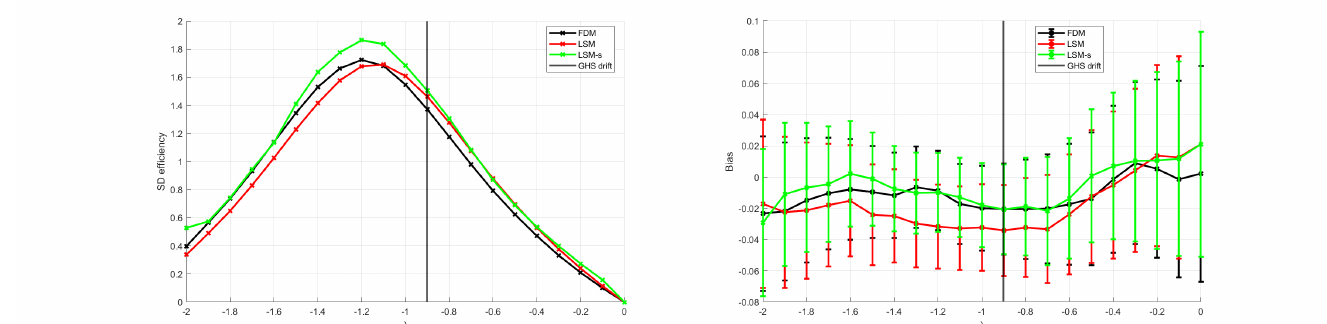
Figure 1. Standard deviation efficiency and bias as a function of change in drift λ . Results are for a put option with r = q = 0.06, σ = 0.2, S 0 = K = 40, T = 1, which is priced using N = 10 4 paths. The three lines correspond to optimal, labeled FDM, and LSM and LSM-s estimates obtained with a polynomial of order 3 in the cross-sectional regressions, respectively. The error bars around the bias illustrate 95% confidence